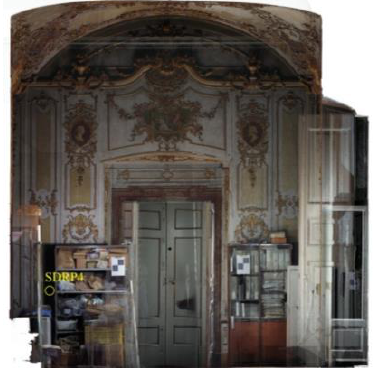
Figure 7. Laser scanner survey of the Gabinetto of gilded stucco. Wall 3 with sampling